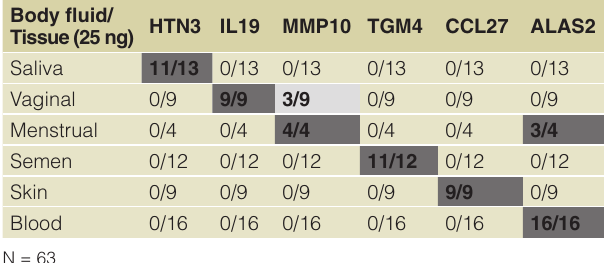
Table 4. ‘All body fluids’ hexaplex HRM assay specificity. The number of single source samples from different individuals in which the marker was successfully detected (numerator) is displayed out of the total number of individuals tested (denominator). The shading reflects the number of positive samples out of the total number tested: white – no detection, light grey 1–74%; dark grey ≥